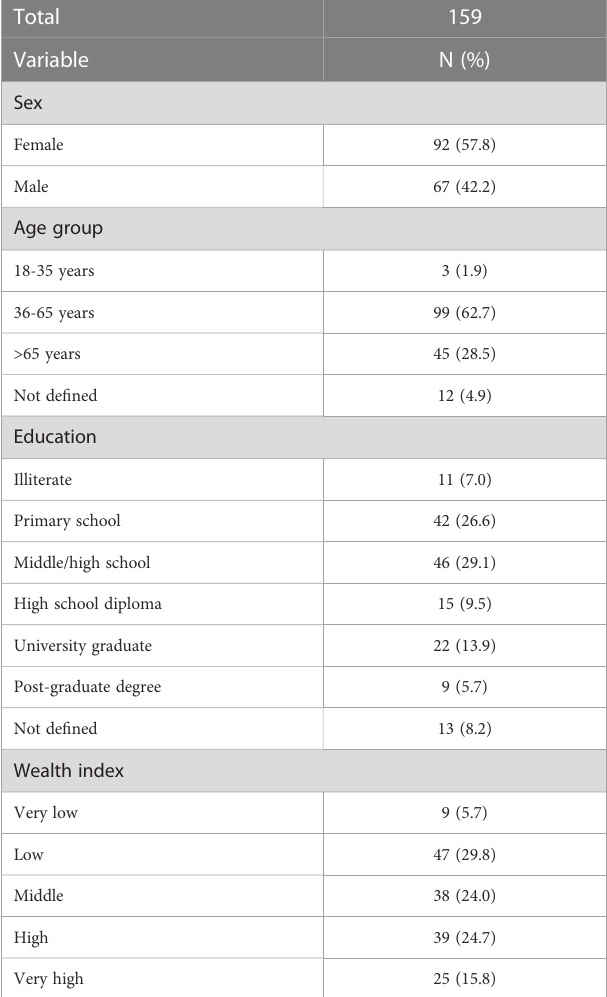
Table 4 conveys the direct and indirect costs of diabetes. The